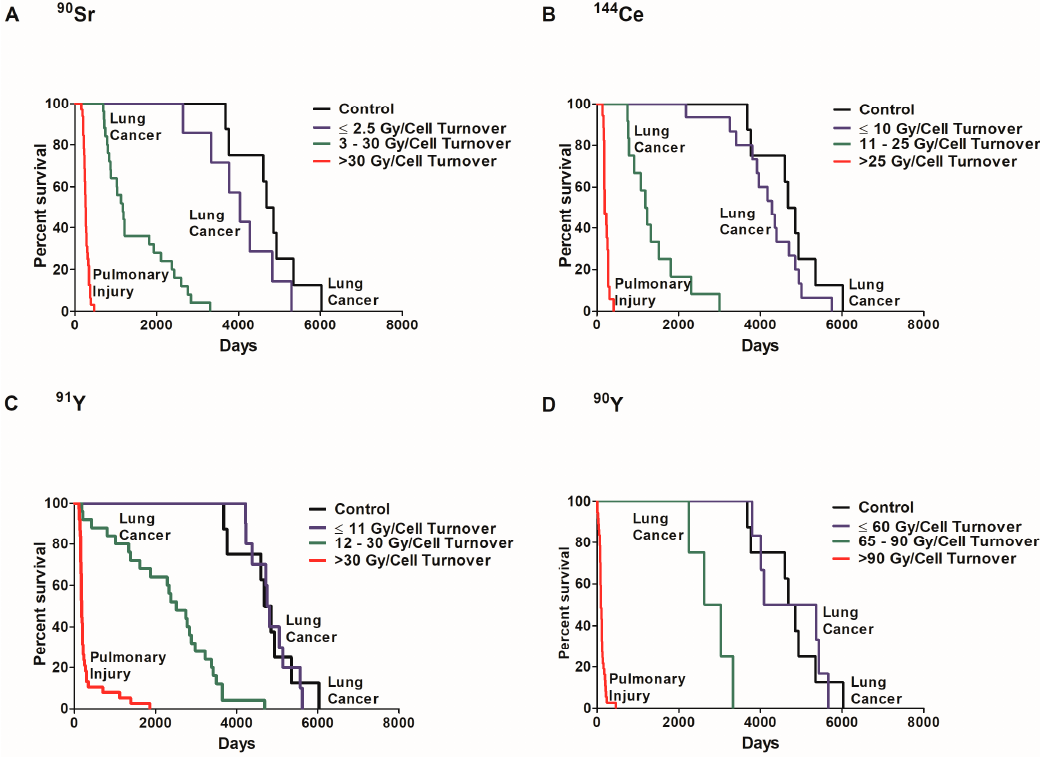
Figure 4. A Kaplan–Meier plot of dose per cell turnover on survival is shown along with the cause of death for each group. The percent survival of exposed and control dogs was plotted against days to death following inhalation of 90 Sr ( A ), 144 Ce ( B ), 91 Y ( C ), and 90 Y ( D ) in fused aluminosilicate particles of dogs that had lung cancer or pulmonary injury. Three distinct dose groups represent Gy/cell turnover: no significant life shortening or increased cancer frequency compared to control, significant life shortening with a very high lung cancer frequency and acute deaths ( p < 0.05). Such data support the need for non-linear dose response functions and a change of paradigms toward total tissue responses and away from a single cell response.